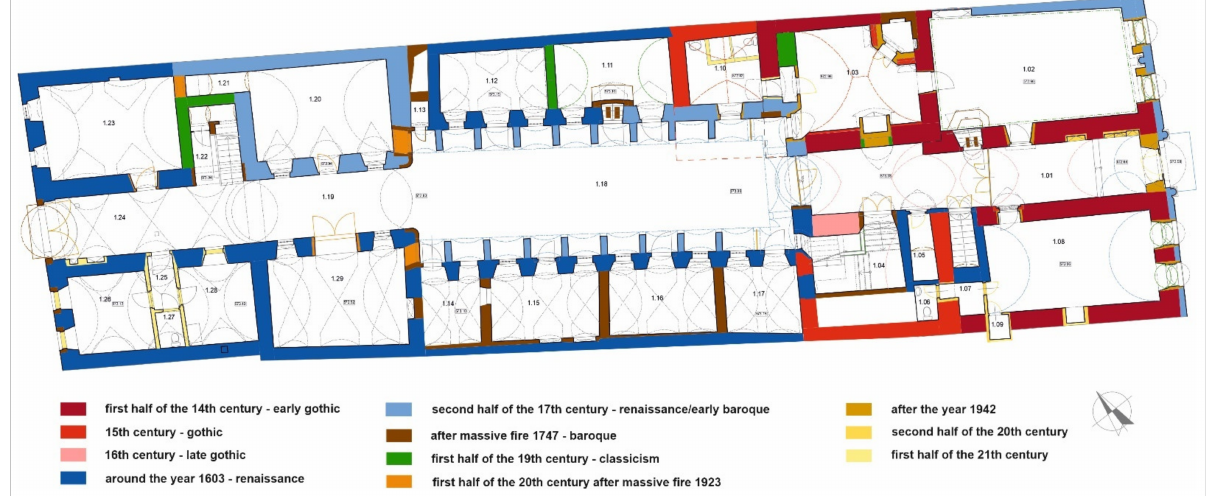
Figure 3. Stylistic analysis and origin of the structures